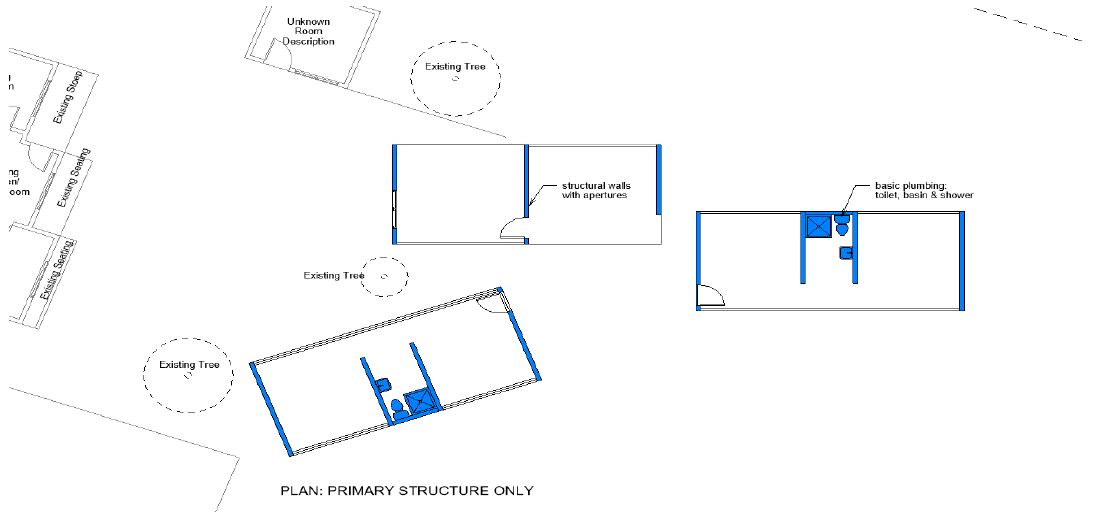
Figure 10: Primary level (blue) completed. By author,